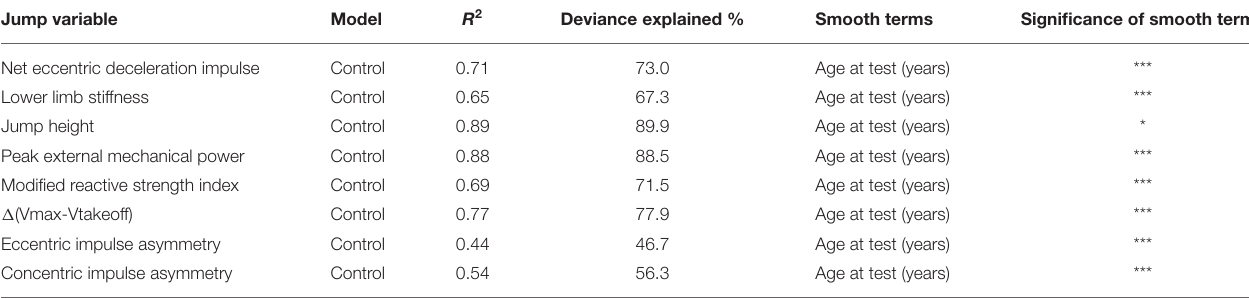
TABLE 2 | Model results for the non-injured controls vs. chronological age.